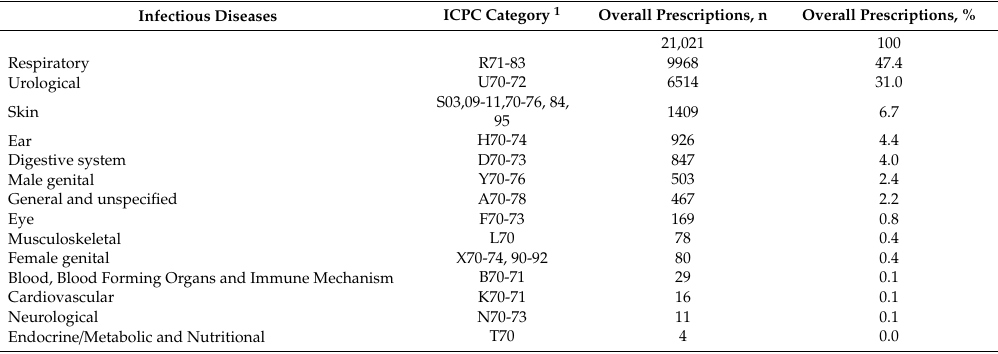
Table 3. Antibiotic prescriptions for infectious diseases by ICPC-2 diagnosis and anatomic groups.